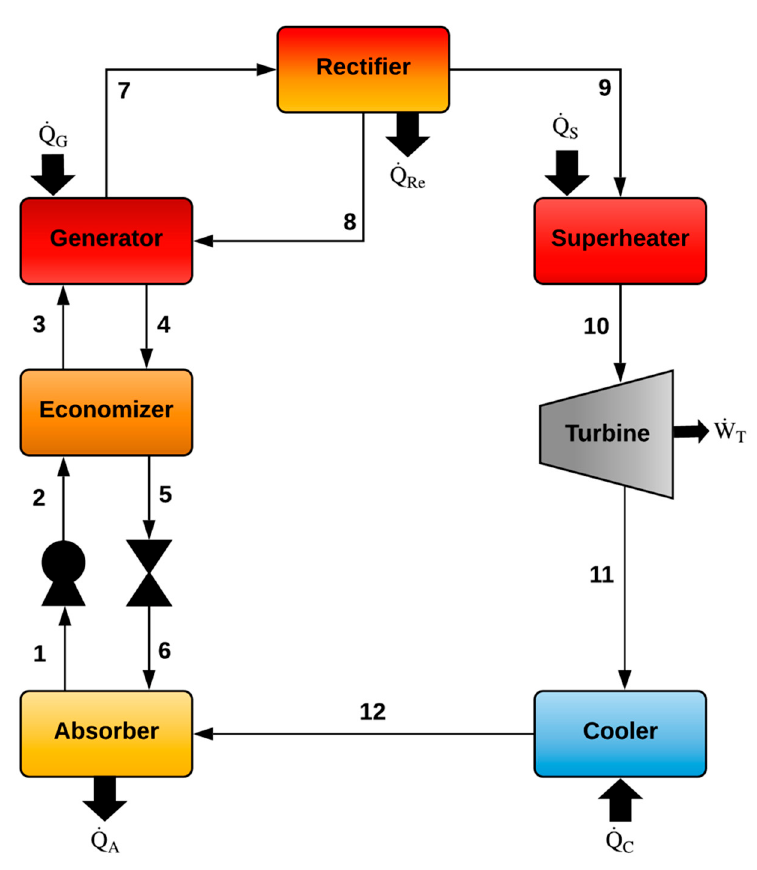
Figure 1. Goswami Figure 1. Goswami cycle.